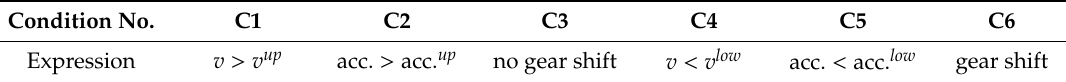
Figure 9. A simplified diagram of the hybrid powertrain operating modes. Table 5. Basic conditions for the transitions between the hybrid powertrain modes.